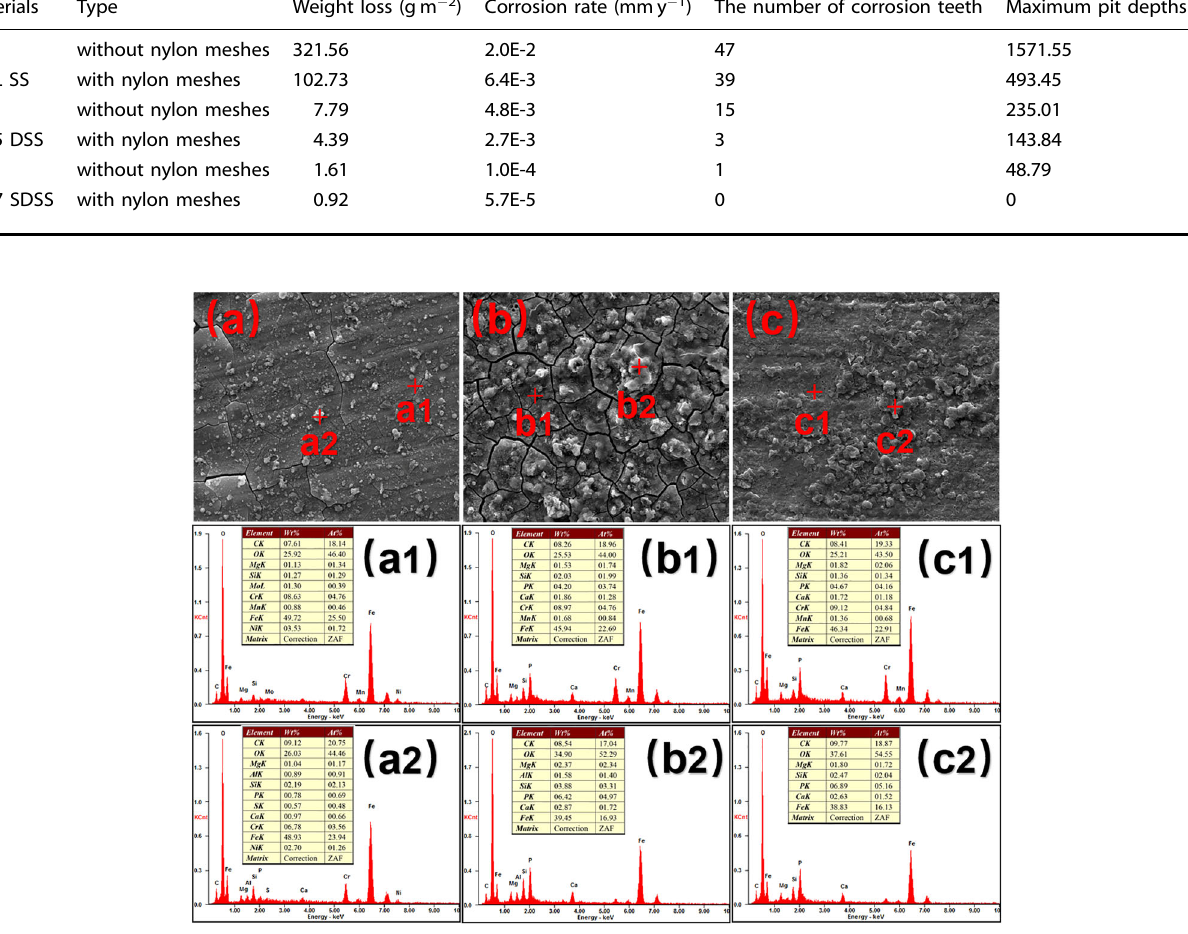
Fig. 9 Surface morphologies and composition information of the corrosion products of three stainless steels. a 316L SS, b 2205 DSS, c 2507 SDSS. 1 -plane, 2 -spherical particles.